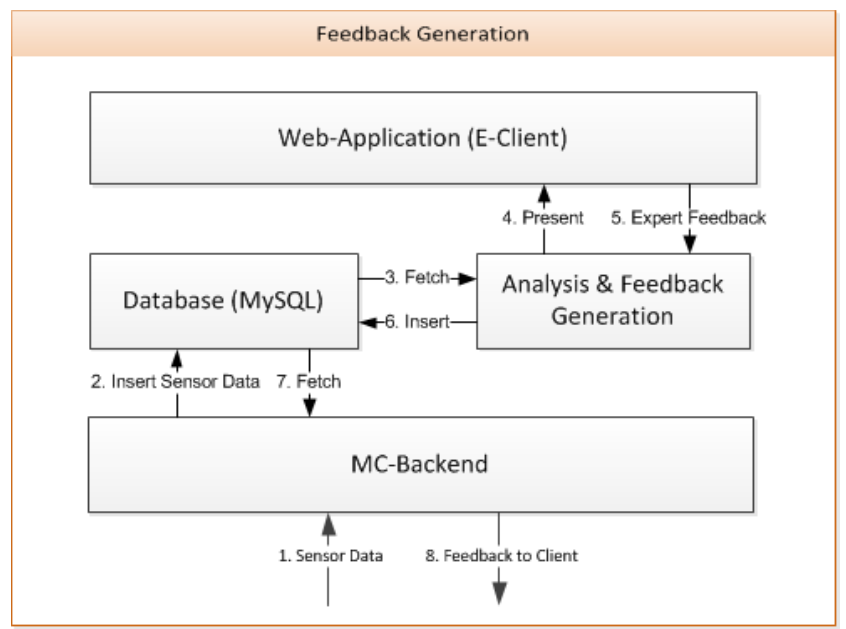
Figure 9. Feedback